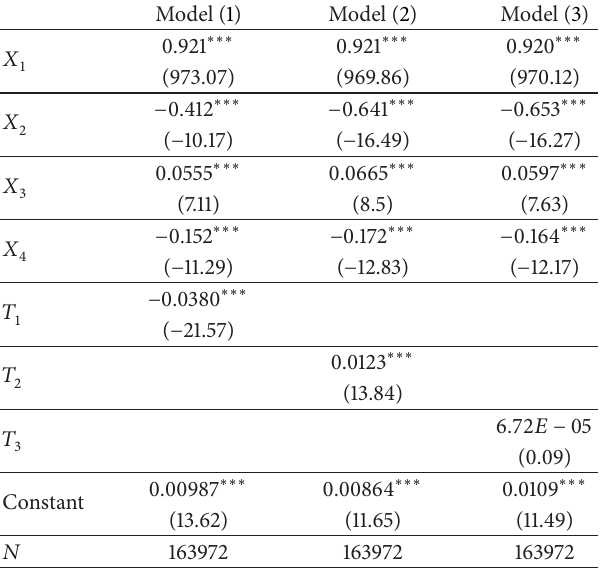
Table 2: Ordinary least squares estimation (1). Table 3: Ordinary least squares estimation